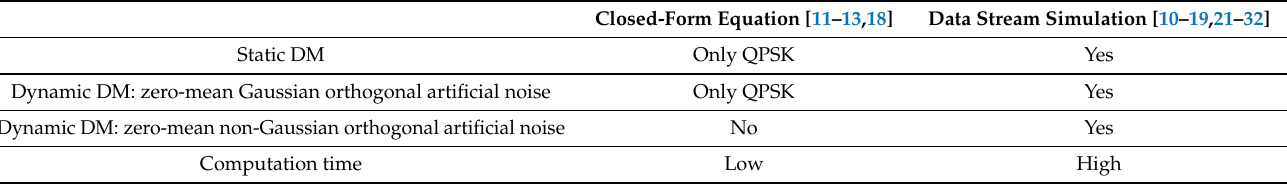
Table 1. Directional modulation (DM) system performance assessment: bit error rate (BER) evaluation techniques Closed-Form Equation